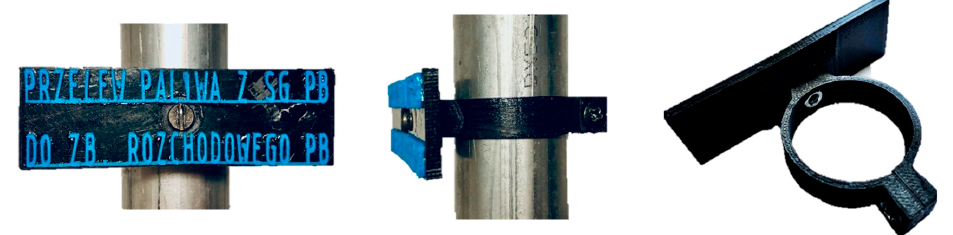
Figure 17. Photos of the plate and mounting produced in fused deposition modeling (FDM) technology.